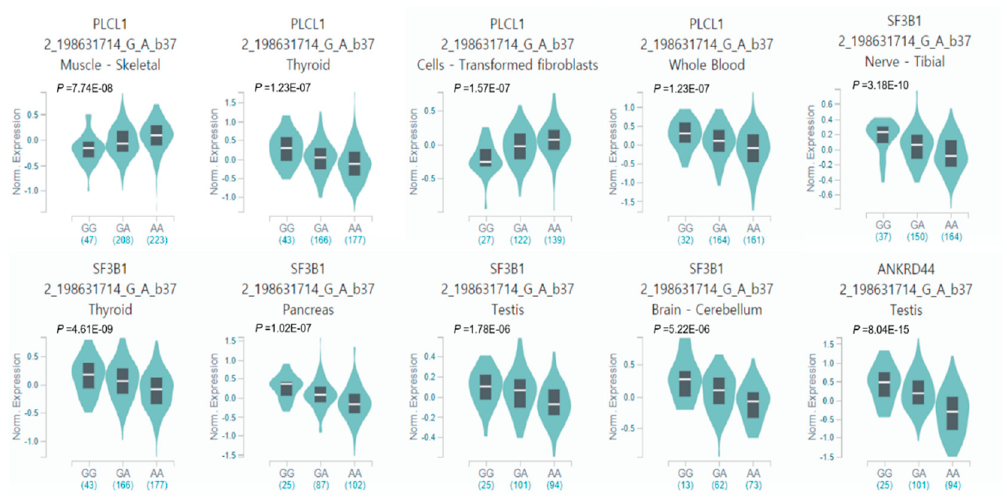
Figure 4. Violin plots of allele-specific cis-eQTLs according to rs700651 genotypes (2_198631714_G_A_b37) in human tissues in the Genotype-Tissue Expression (GTEx, release v7 and human genome build 37) database ( p < 1 × 10 − 6 ). G and A alleles indicate the reference (minor) and alternative (major) allele types, respectively. The teal region indicates the density distribution of the samples in each genotype. The white line in the box plot (black) shows the median value of the expression of each genotype.